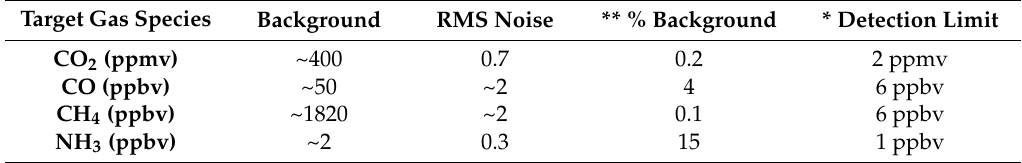
Table 5. Detection limits and RMS for OP-FTIR for selected species determined as one std dev of 5-min measurements made under turbulent atmospheric conditions. Detection limits are defined as 3 × RMS noise. Target Gas Species Background RMS Noise ** % Background * Detection Limit CO 2 (ppmv) ~400 0.7 0.2 2 ppmv CO (ppbv) ~50 ~2 4 6 ppbv CH 4 (ppbv) ~1820 ~2 0.1 6 ppbv NH 3 (ppbv) ~2 0.3 15 1